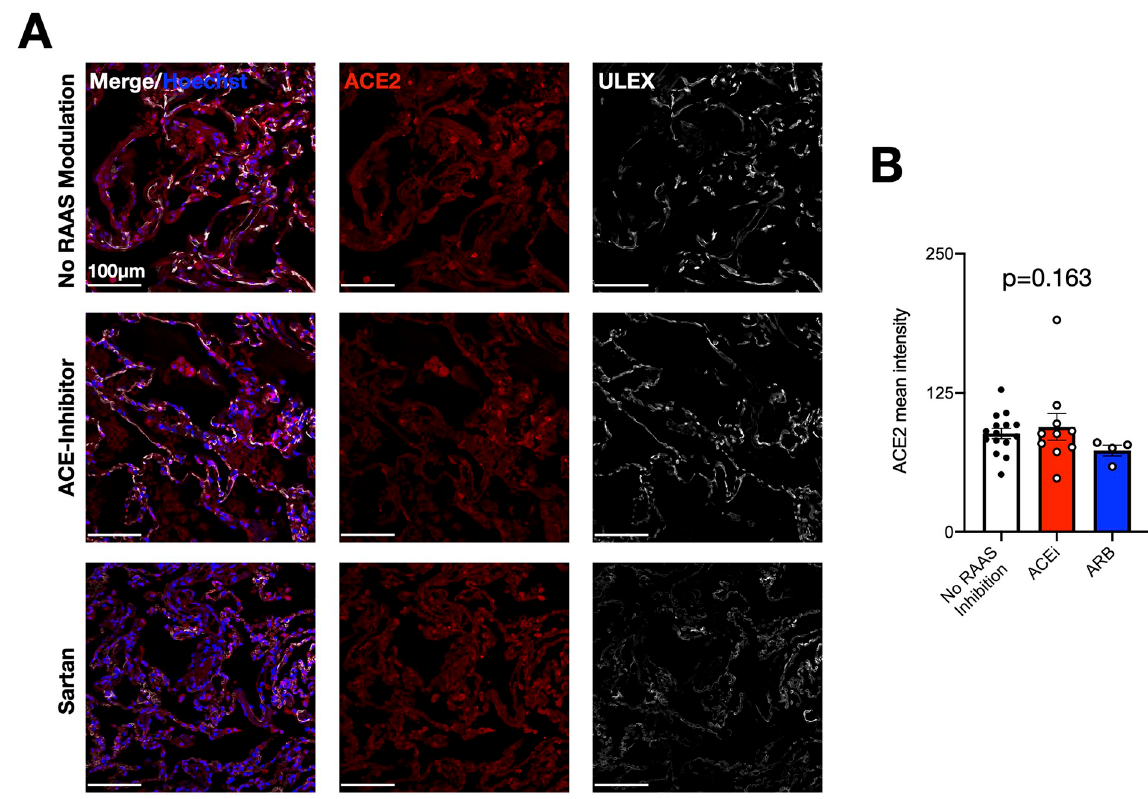
Fig 6. ACEi or ARB do not affect expression of ACE2 in lung epithelial cells. (A) Lung stainings of patients without RAAS modulators, with ACEi treatment and ARB medication for ACE-2 (red), Hoechst (blue) and Ulex (white). (B) Quantification of ACE-2 expression mean intensity, arbitrary units. mean ± SEM;